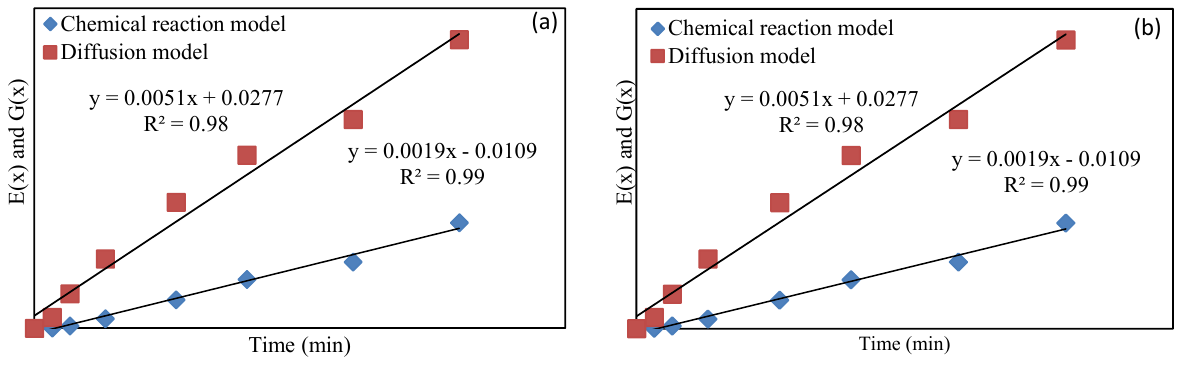
Fig. 6. Comparison between measurements and correlations expressing diffusion and chemical reaction-controlled regimes: (a) for the bioleaching of Cu, (b) for the bioleaching of